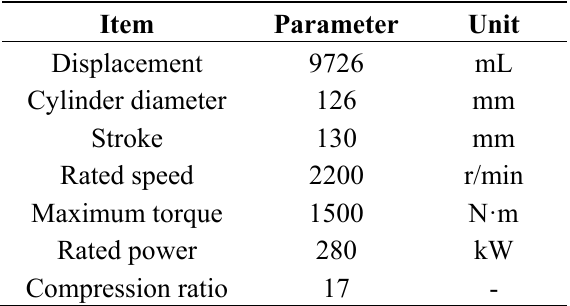
Table 1. Main parameters of the diesel